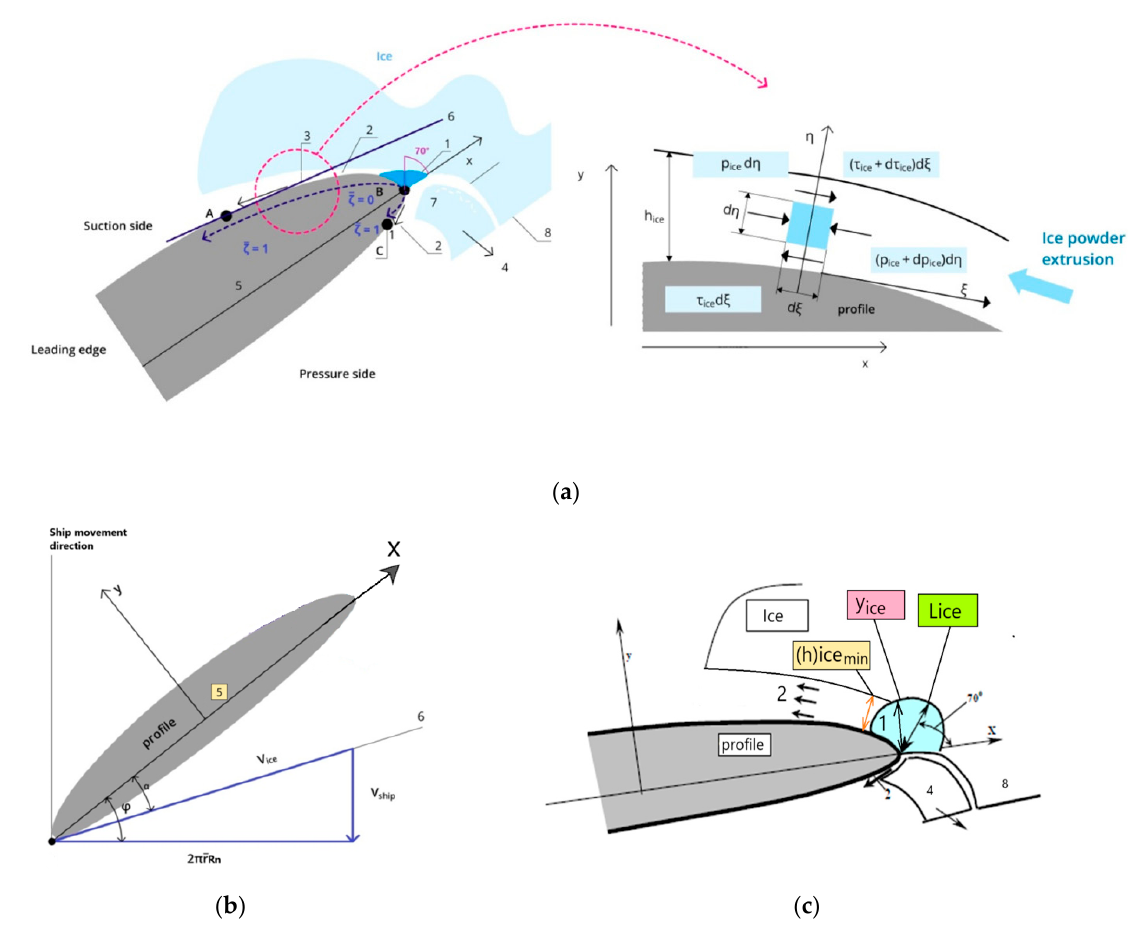
Figure 3. ( a ) Ice powder extrusion process and equilibrium condition of an ice powder element [5,7]; ( b ) Coordinate systems used and profile velocities during propeller/ice interaction; ( c ) Ice- crushing zone. AB—contact zone from the suction side; BC—contact zone from the pressure side; 𝜁̅ ∈ [0,1] —dimensionless ice contact zone along pressure and suction sides of a profile, 0— beginning of a contact zone (point B); 1—end of a contact zone (points A, C); 1—ice crushing zone; 2—ice channel; 3—ice powder; 4—split fragment; 5—profile chord; 6—line of attack angle; 7— splitting crack; 8—ice free surface; α —attack angle; φ —pitch angle; V ship —ship speed; V ice —ice con-